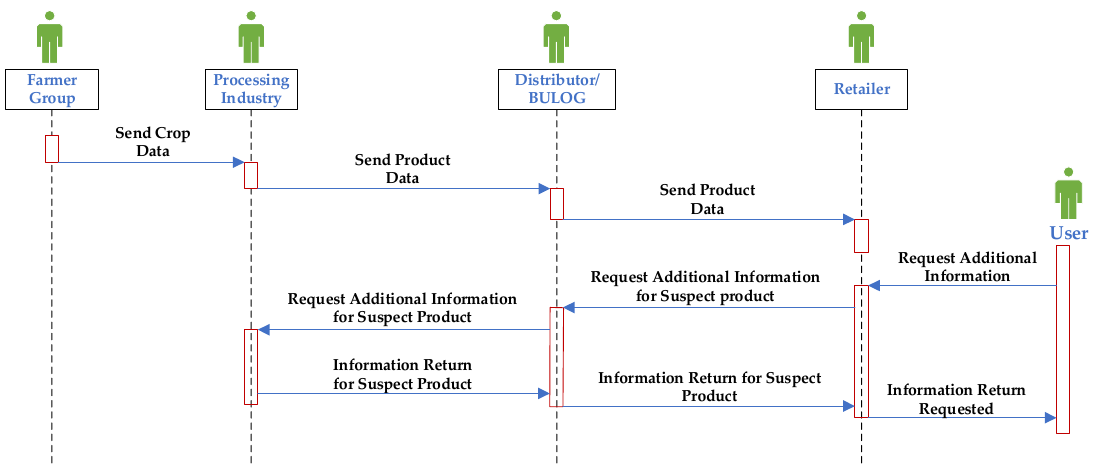
Figure 7. Sequence diagram for exchange of information in rice supply chains.